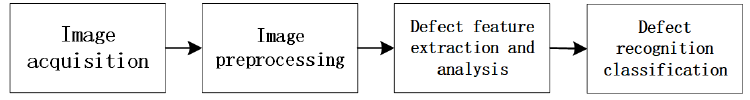
Figure 1. Inspection and treatment process of appearance